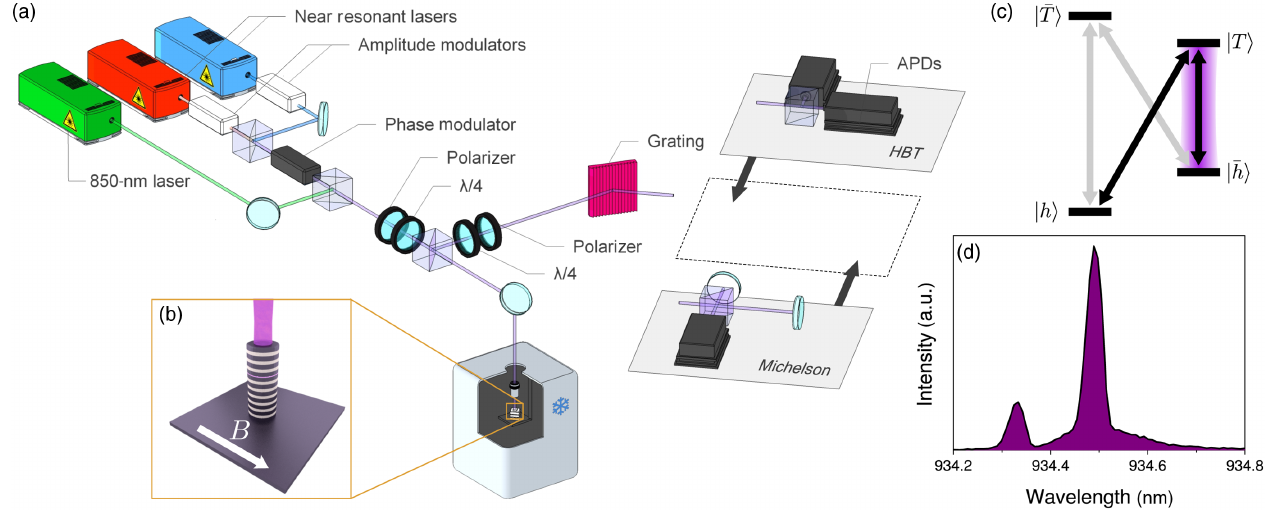
FIG. 1. (a) An illustration of our experimental setup. (b) An illustration of a micropillar cavity in a Voigt geometry magnetic field. (c) The energy-level diagram. When the resonant lasers are red or blue detuned from the diagonal transition, the resulting Raman scattered light is similarly detuned. (d) The spectrum of the QD under nonresonant excitation. Polarization filtering ensures that only the vertical transitions are visible, and the long-wavelength transition is clearly enhanced by the cavity